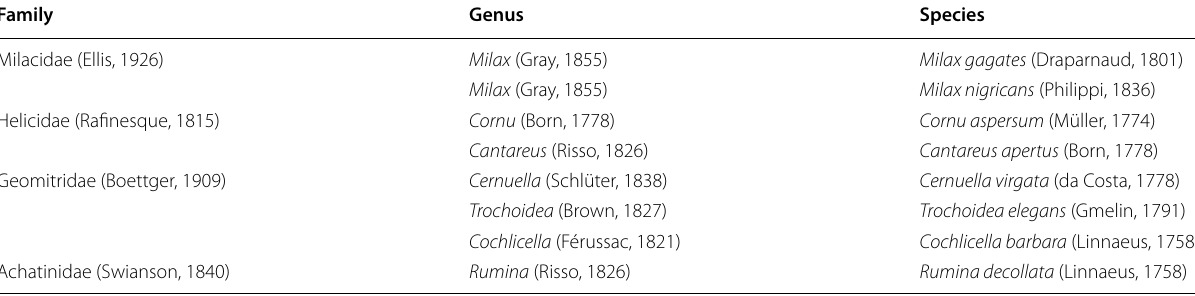
Table 2 List of malacological species in the three study sites Family